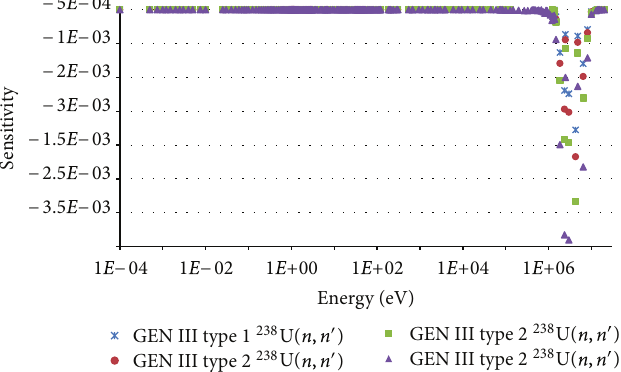
Figure 14: The sensitivity of 238 U( 𝑛,𝑛 󸀠 ) as function of